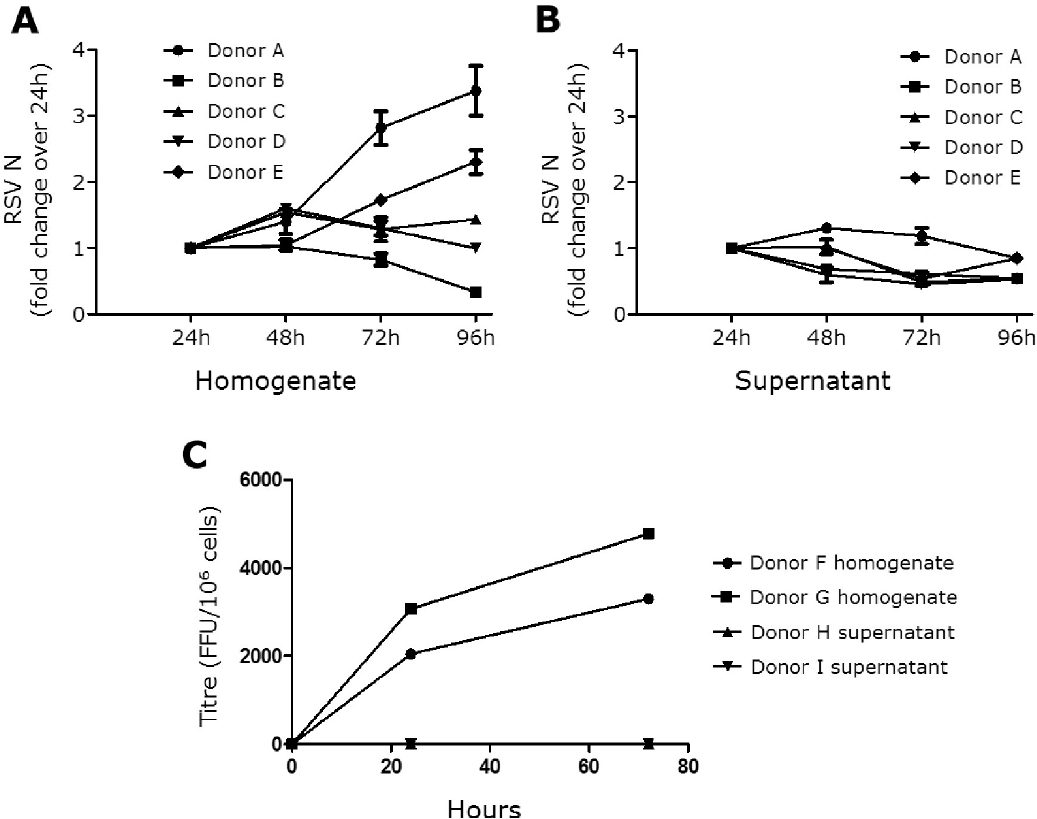
Fig 3. RSV infection kinetics in Hofbauer cells. (A) Expression of RSV nucleocapsid (N) RNA transcripts measured in lysates of Hofbauer cells infected with rrRSV at MOI of 1 using ß-actin as housekeeping gene. Fold changes were calculated using the 24-hour time-point as baseline to demonstrate growth kinetics between cell homogenate and supernatants. Data are shown as mean ± SEM of 5 different donors. (B) RSV N RNA transcripts in supernatants matching the cell homogenates shown in panel A and normalized based on input volume. RSV N transcription increased in cell homogenates of 4 of the 5 analyzed donors, whereas no increase was observed in the corresponding supernatants. (C) Viral titers measured at 24- and 72-hours post-infection with rrRSV at MOI of 1 using a fluorescence-focused unit (FFU) assay. Whereas viral replication within Hofbauer cells was detected at 24 hours and increased by 72 hours, no virus was found in the corresponding supernatants at either time-point.